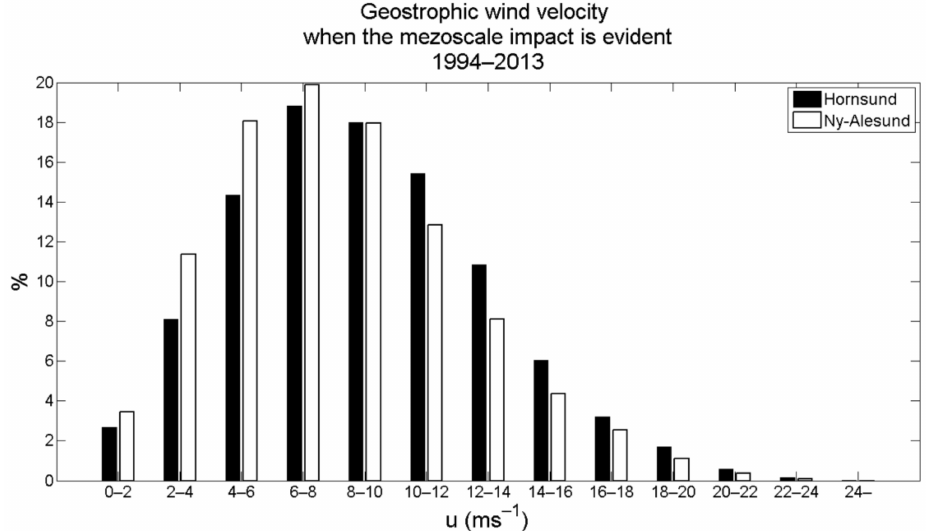
Figure 5. The distribution of large-scale wind speed from the NCEP/NCAR reanalysis at Hornsund and Ny-Ålesund stations when the mesoscale land-sea breeze type circulation was recorded, 1994– 2013. Black—Hornsund,